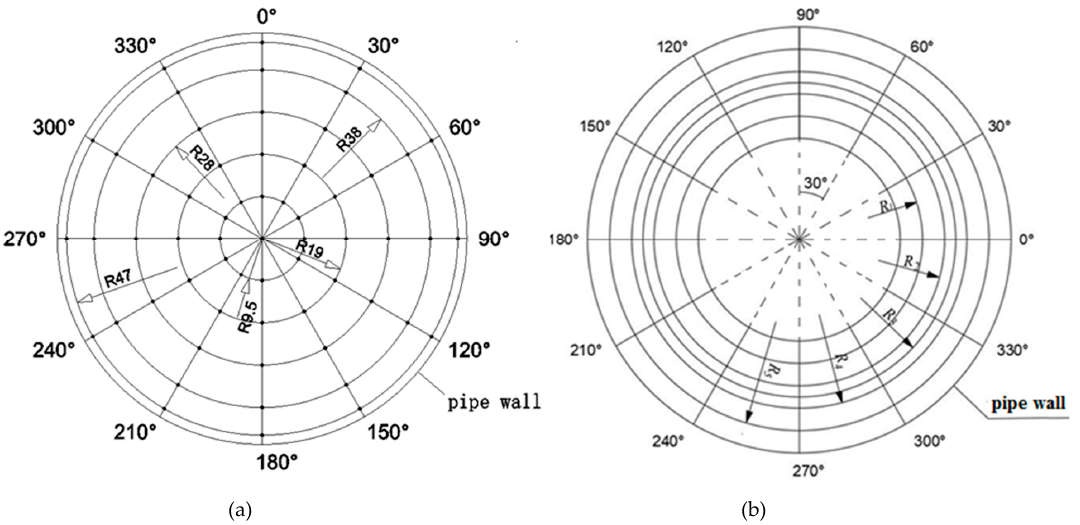
Figure 3. Layout of measuring points of sections: ( a ) the front and rear sections of capsule and ( b ) the annular gap section.